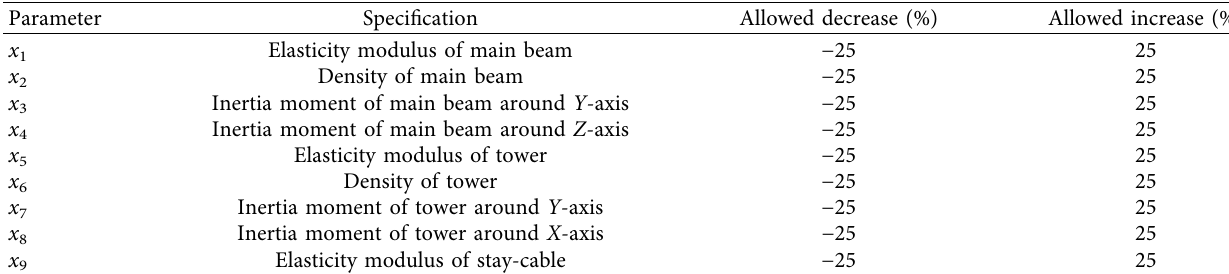
Table 3: Design variables.